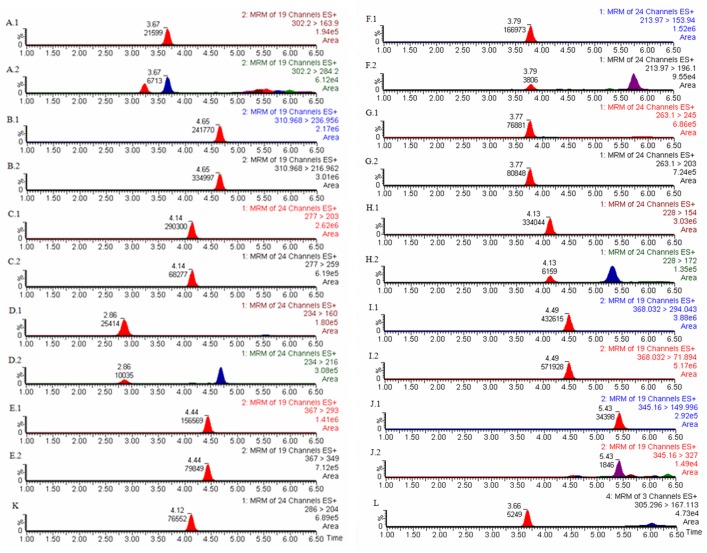
Daughter ion chromatograms of 10 β2-agonists.